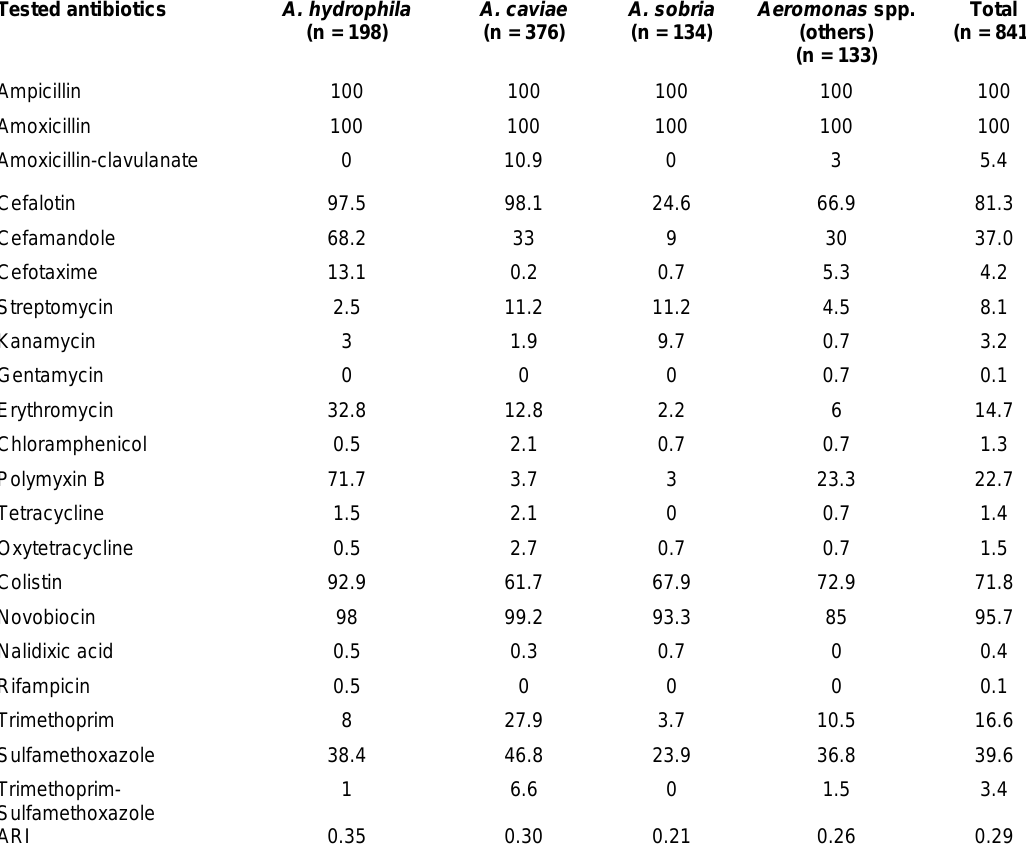
Percent Antibiotic Resistance among Aeromonas spp. Isolated from the Riverine Samples Tested